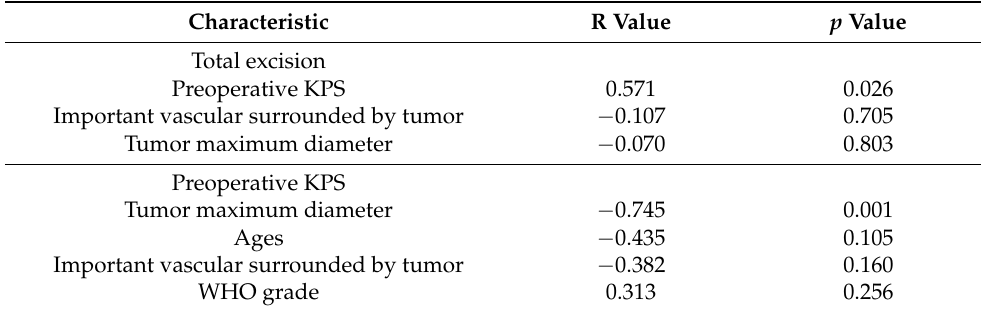
Table 3. The risk factors correlated with resection degree were determined by Spearman correlation